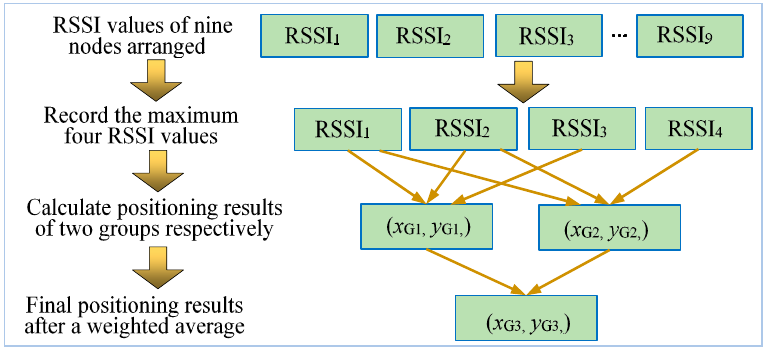
Figure 5. The specific implementation process of iterative positioning.